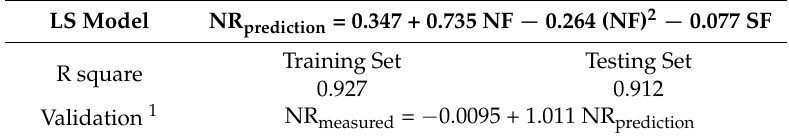
Table 3. Statistical model results for operating mode 1